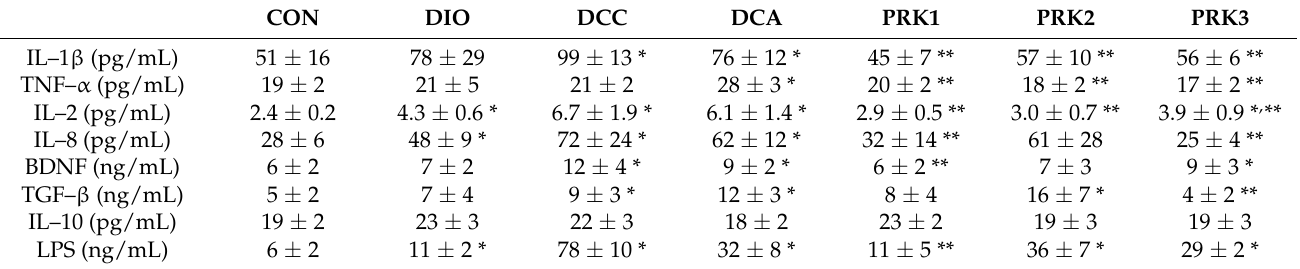
Table 3. Serum concentrations of cytokines, brain-derived neurotrophic factor, and lipopolysaccharide in Wistar rats at the end of the experiment ( n = 10 in each group). The results show mean values ±